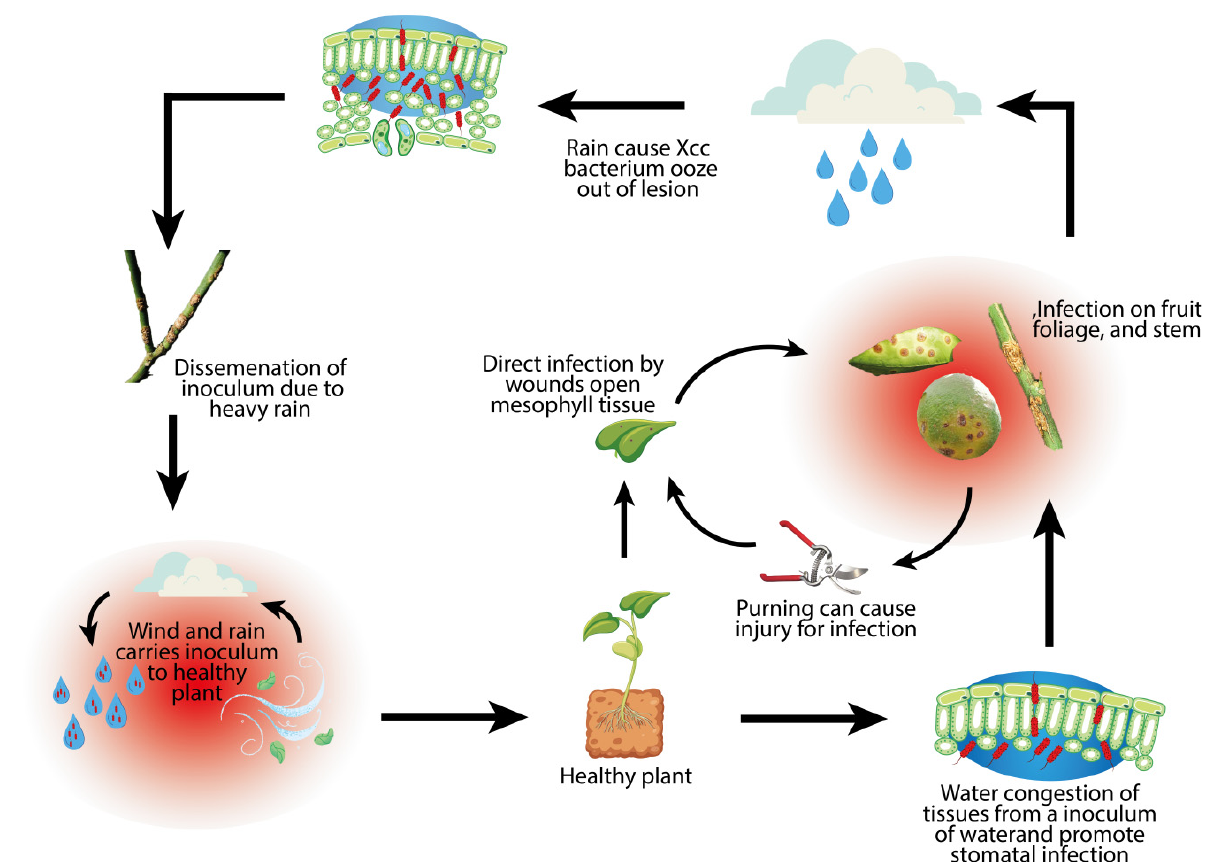
Figure 4. Model illustrating the Xanthomonas citri subsp. citri bacterium initiating local infection into leaves, twigs, and fruits. The Xcc survival cycle begins when the pathogen enters a plant through a natural opening or wound. The pathogen then multiplies in the plant tissue and produces cankers. The cankers ooze a sticky exudate that contains the pathogen. The exudate dries and forms a crust on the surface of the canker. When the exudate comes into contact with a new plant, the pathogen can enter the plant and cause a new canker.